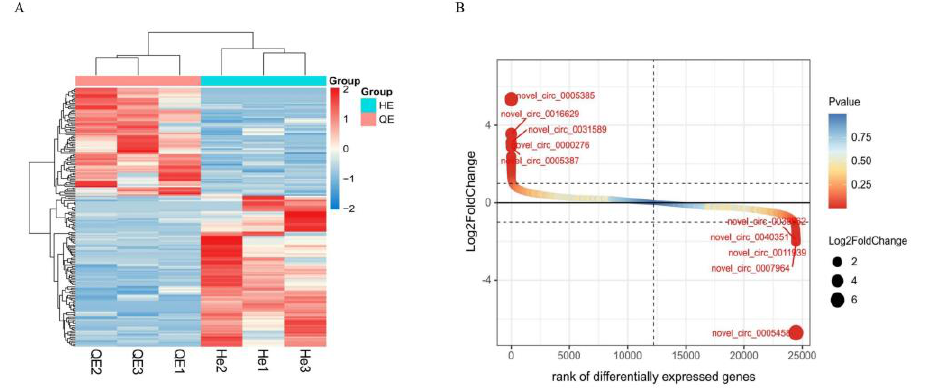
Figure 2. Differentially expressed circRNAs. ( A ) Heat map of DEcircRNAs. Each column shows one sample and each row represents one circRNA. ( B ) Bubble-rank plot of differential gene expression of RNA-seq.